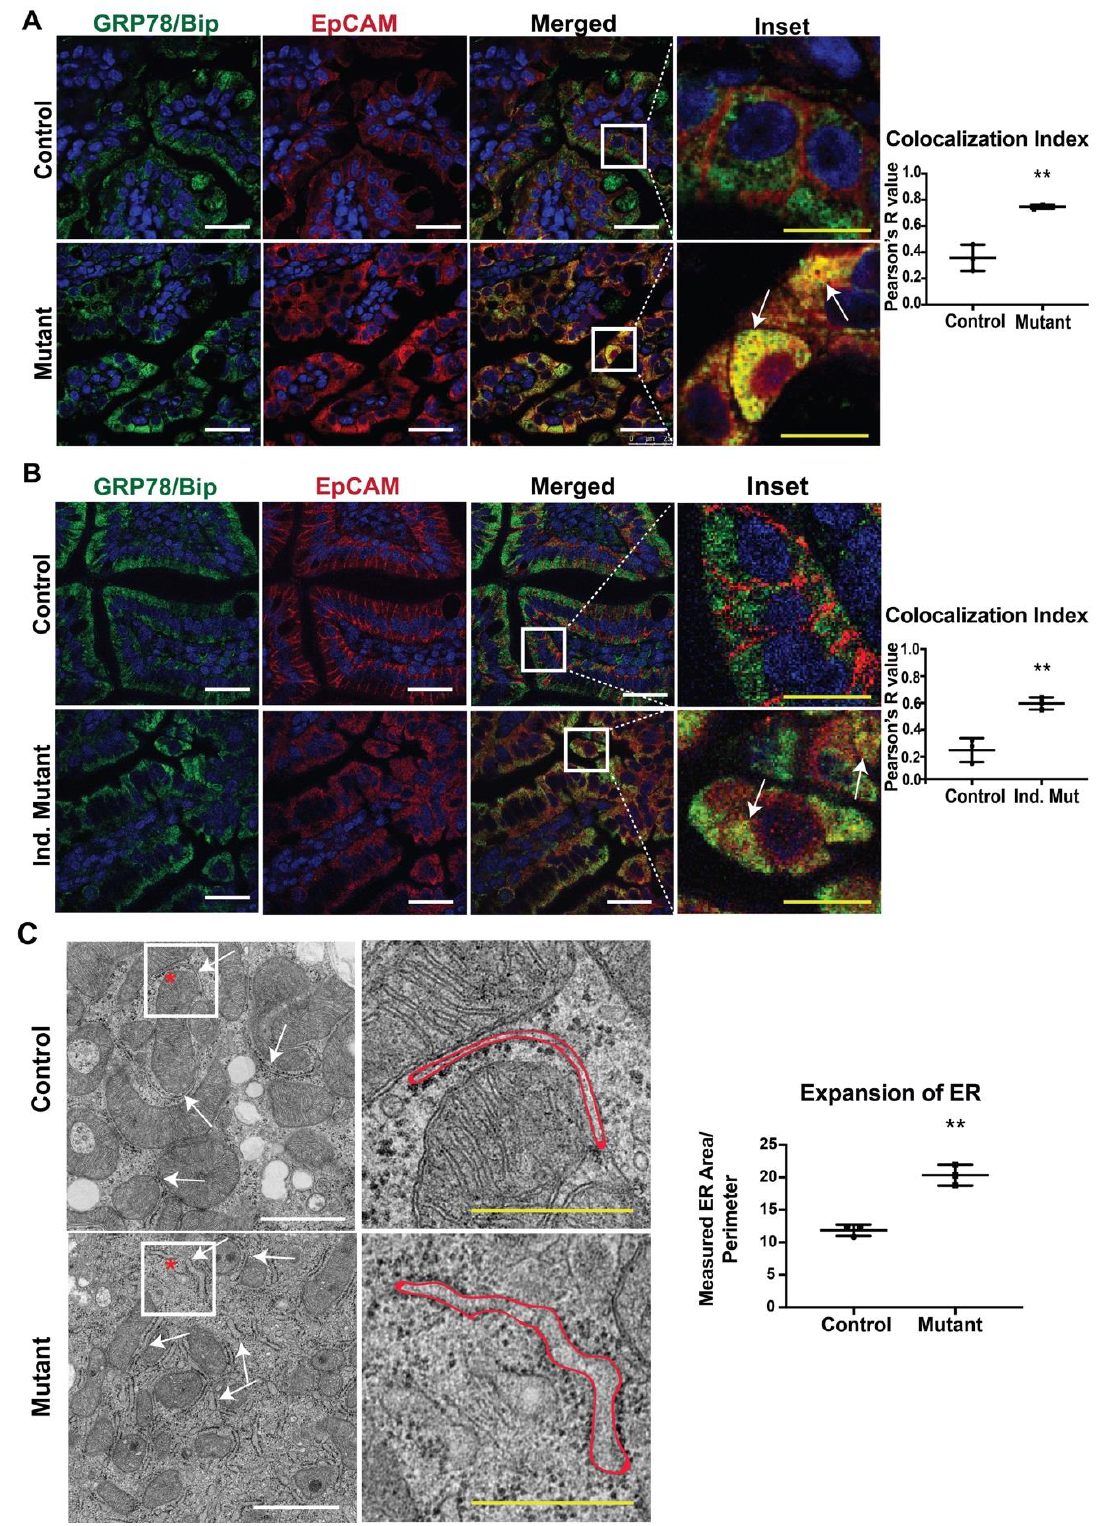
Figure 1. Co-localization of mutant epithelial cell adhesion molecule (EpCAM) with GRP78/BiP endoplasmic reticulum (ER) Marker: Representative confocal images of an intestinal tissue section from ( A ) neonates and ( B ) adult mice showing GRP78 / BiP (green), EpCAM (red) and merged images of respective Control and Mutant/Inducible (Ind.) Mutant mice ( n = 3). The right most panel depicts the enlarged inset image of the selected region from the merged images. Mutant EpCAM co-localizes with the major ER chaperone, GRP78/BiP, as depicted by yellow color (marked with arrows in inset). White scalebar represents 25 μm and the yellow scalebar represents 10 μm in all of the images for ( A )